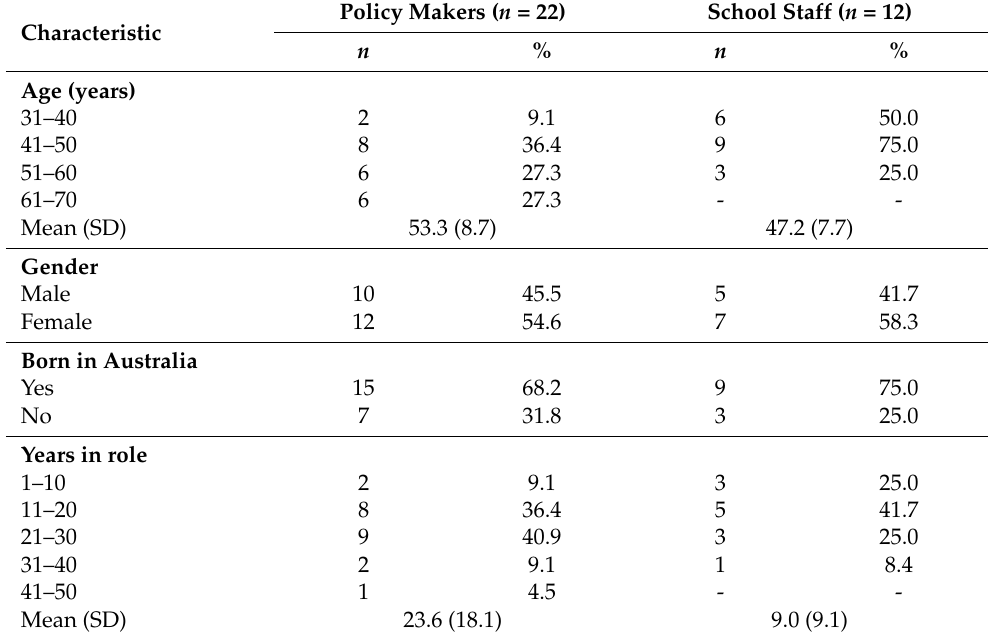
Table 1. Characteristics of study participants.